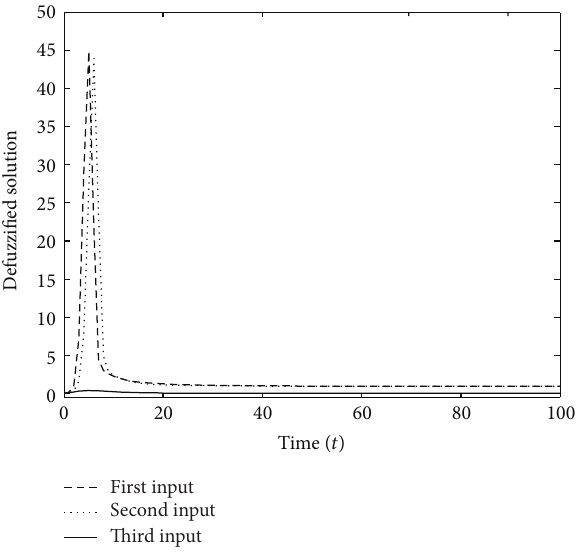
Figure 9: Defuzzified solution for infected CD4 + T lymphocytes of system (3) for the three